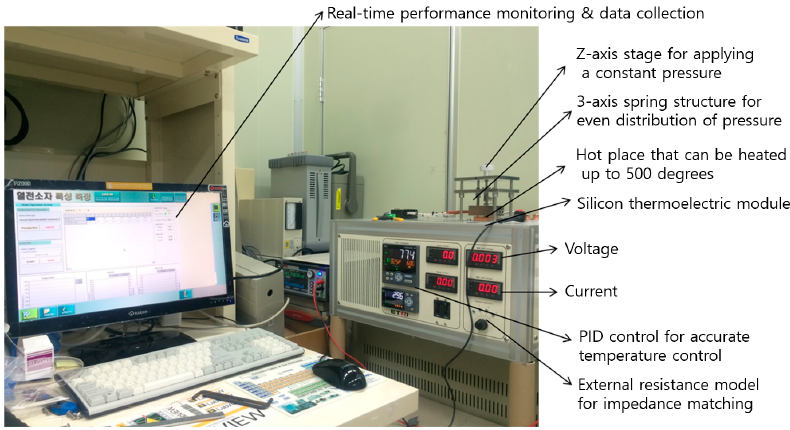
Figure 7. The evaluation set-up for 3D thermoelectric module.